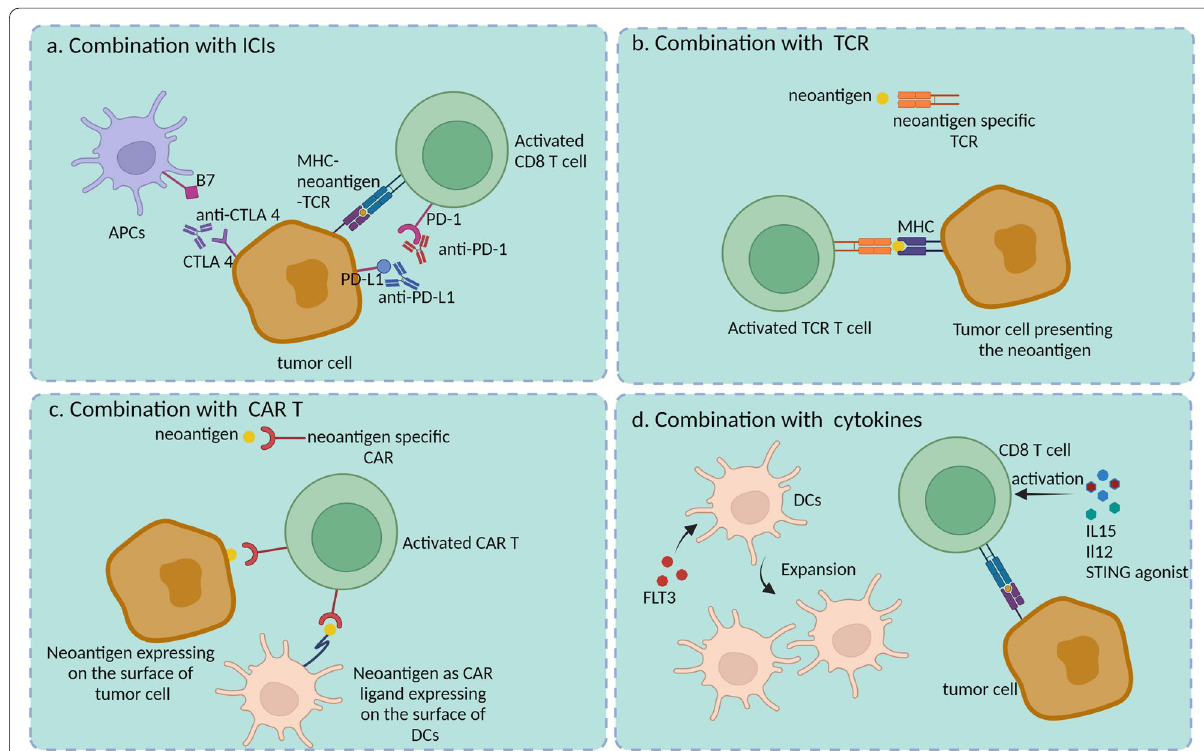
Fig. 4 Combination of neoantigen vaccines with other therapied for cancer. a Combination of neoantigen vaccines with ICI therapy such as anti-CTLA4, anti-PD-1 and anti-PD-L1 could relieve exhaustion of T cells and APCs; b Combination with TCR therapy, T cells were engineered with neoantigens-specific TCR to kill tumor cells; c T cells were equipped with neoantigens-specific CAR which could effectively recognize tumor cells which expressed neoantigens. Even neoantigen can be a CAR ligand to be transferred to the surface of DCs, activating the neoantigen-CAR T cells; d Cytokines induce the expansion of DCs or enhance the activity of T cells to improve the anti-tumor